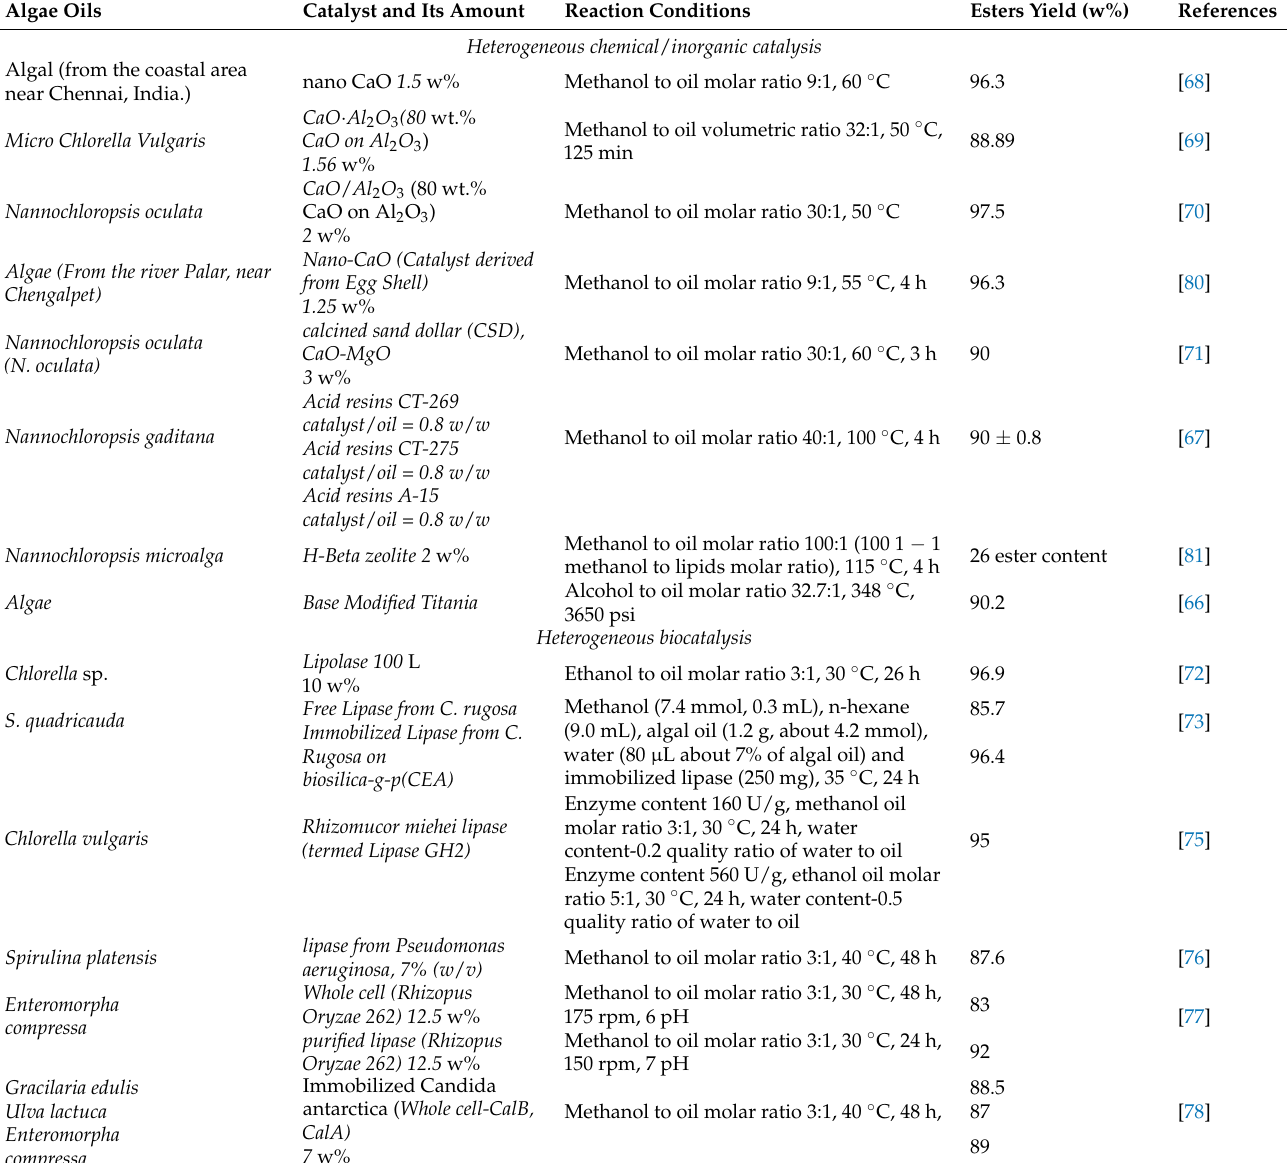
Table 7. Summary of studies of different heterogeneous catalyst